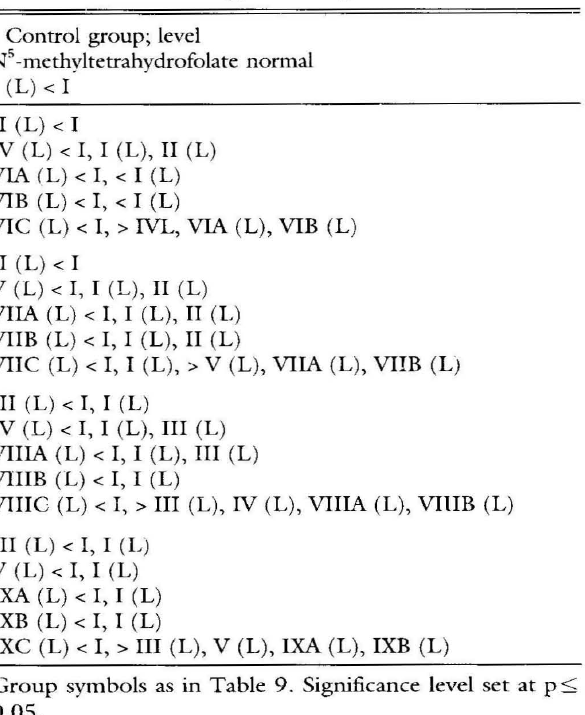
Table 10. Statistically significant differences between the levels of N 5 -methyltetrahydrofolate in the serum of BDF, mice with L1210 leukemia after administration of MTX, FU and combined therapy according to different schedules I Control group; level